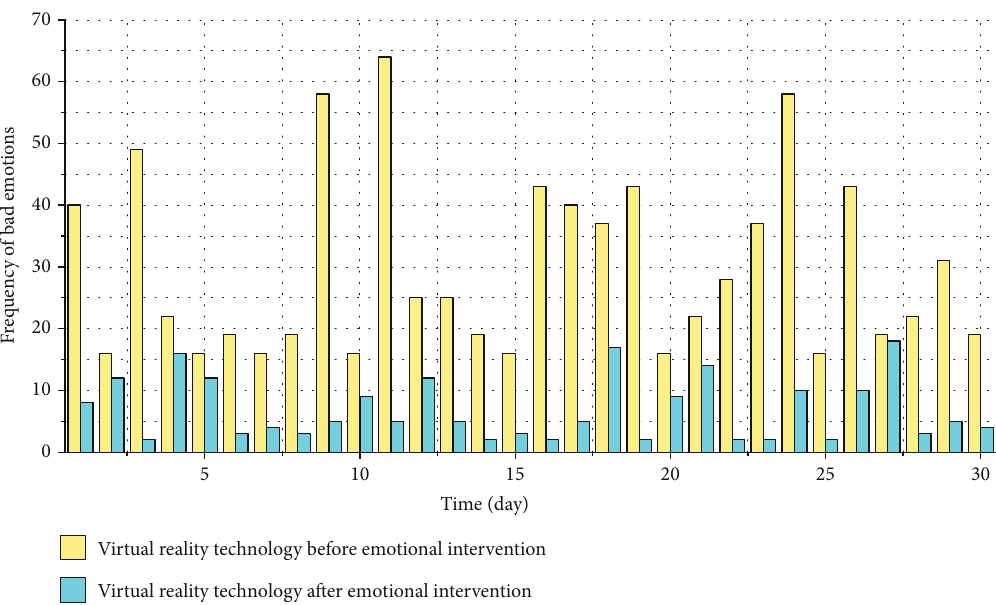
Figure 5: Frequency of adverse emotions before and after virtual reality technology emotional